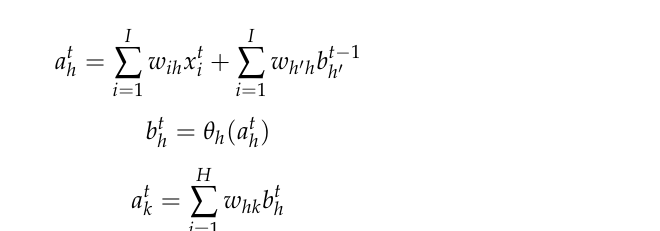
t a represents the calculation output of the hidden layer and t h two parts. The first part is both connected to the input layer and calculated. The second part is the self-connecting of the hidden layer, that is, the output of the hidden layer from parameters between the self-connecting of the hidden layer.